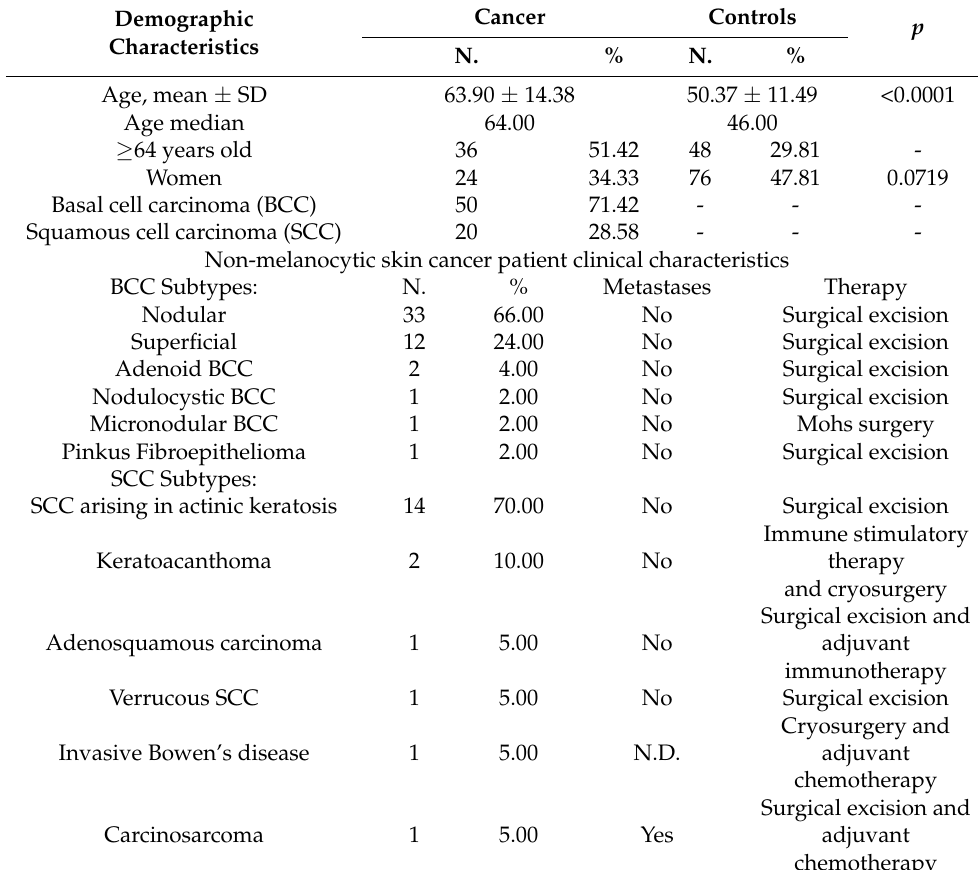
Table 1. Demographic and clinical characteristics of 70 patients with non-melanocytic skin cancer (NMSC) and 161 control